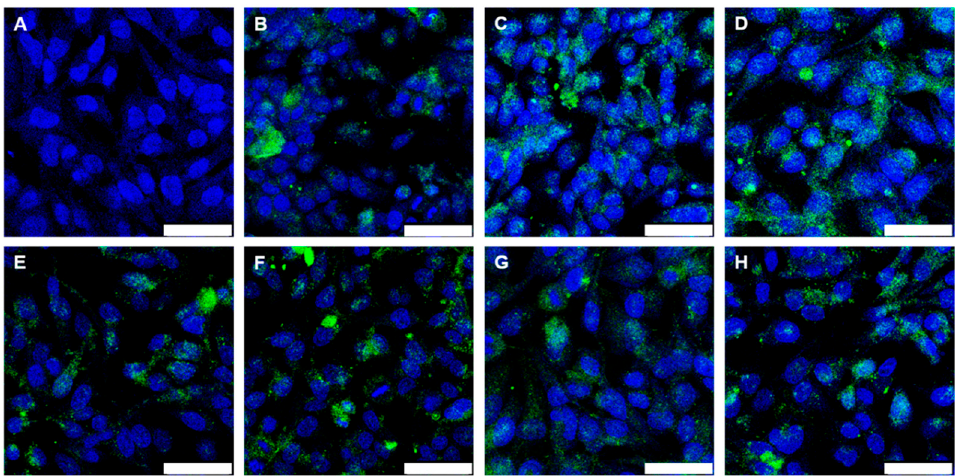
Figure 10. Confocal laser scanning microscopy images of HeLa cells after 24 h cultivation (control; ( A )) and after 24 h incubation with Au-BSA nanoclusters (43 µg mL − 1 Au) ( B ). The uptake of Au-BSA nanoclusters from dissolved capsules is shown in ( C ) for Eudragit (42 µg mL − 1 Au), ( D ) for Eudragit-chitosan (42 µg mL − 1 Au), ( E ) for CAP (45 µg mL − 1 Au), ( F ) for HPMC-Eudragit (50 µg mL − 1 Au), and ( G ) for HPMC-PVA-Eudragit (47 µg mL − 1 Au). ( H ) The uptake of Au-BSA nanoclusters after release from a suppository (52 µg mL − 1 Au). Blue: nucleus; green: Au-BSA nanocluster autofluorescence. Scale bar 50 µm. All given concentrations refer to gold in the cell culture well.